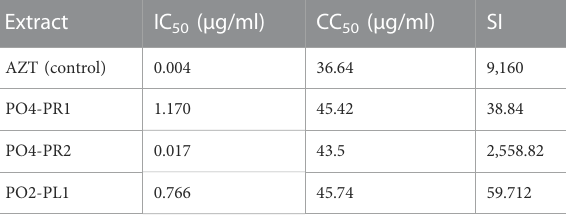
TABLE 3 Inhibition concentration (IC 50 ) and cell cytotoxicity of A. alternata extracts in Luciferase based assay. The selective index was determined by dividing the cell cytoxicity and inhibitory concentration at